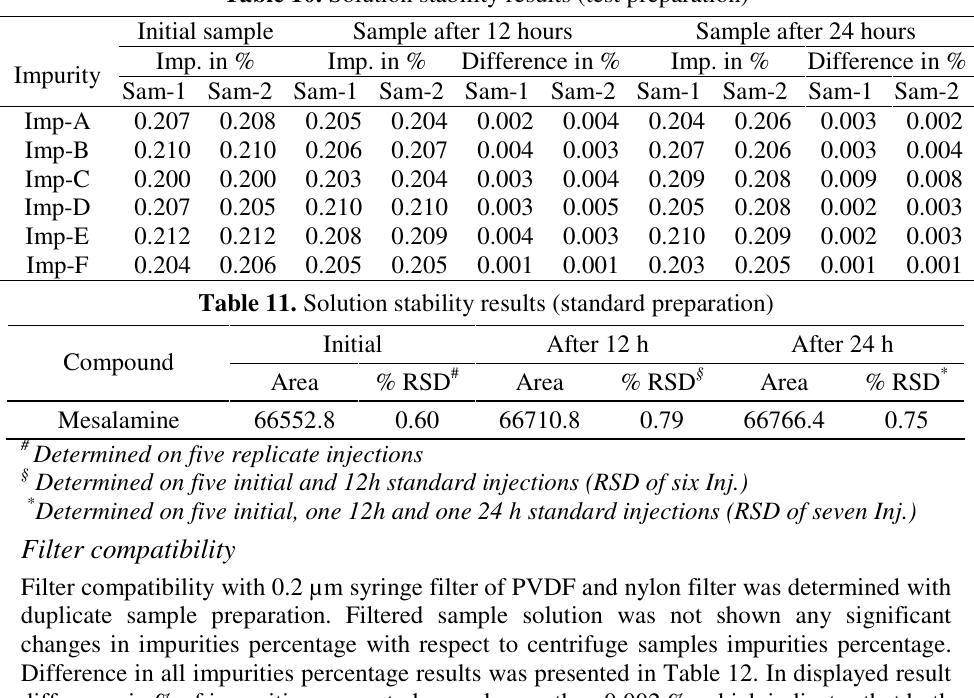
Table 10. Solution stability results (test preparation)